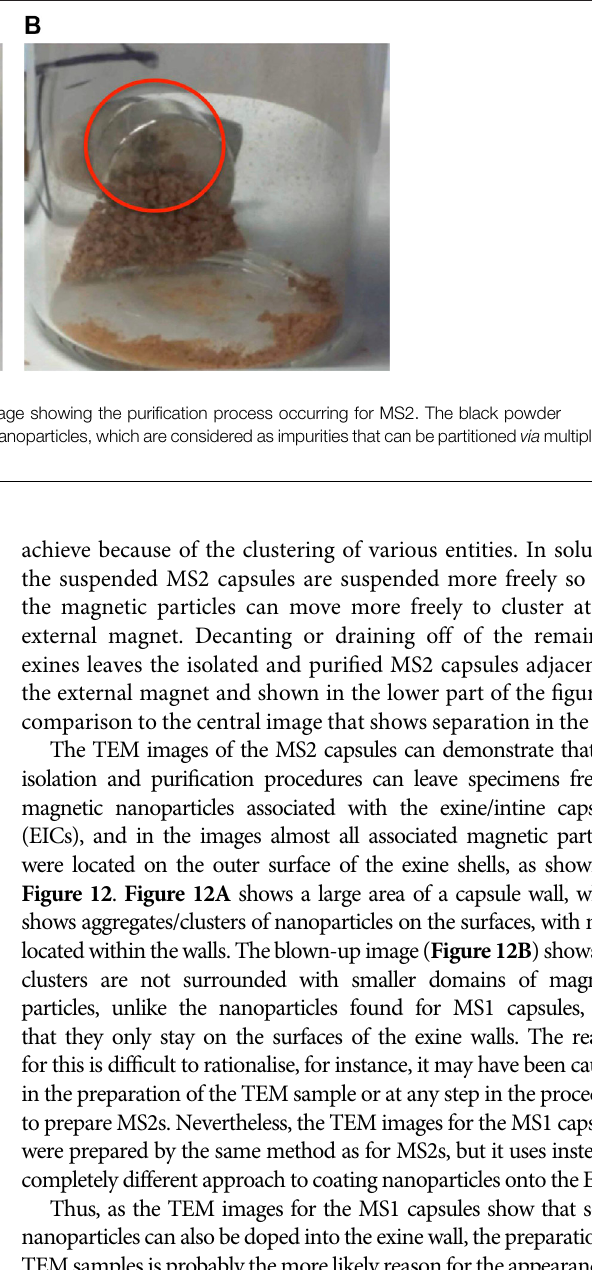
In the bottom part of the fi gure the images show the MS2 capsules suspended in water, whereas the top of the fi gure shows the attraction of the magnetic entities under dry conditions. Partition occurs by dragging the magnetic particles clear of the clusters of